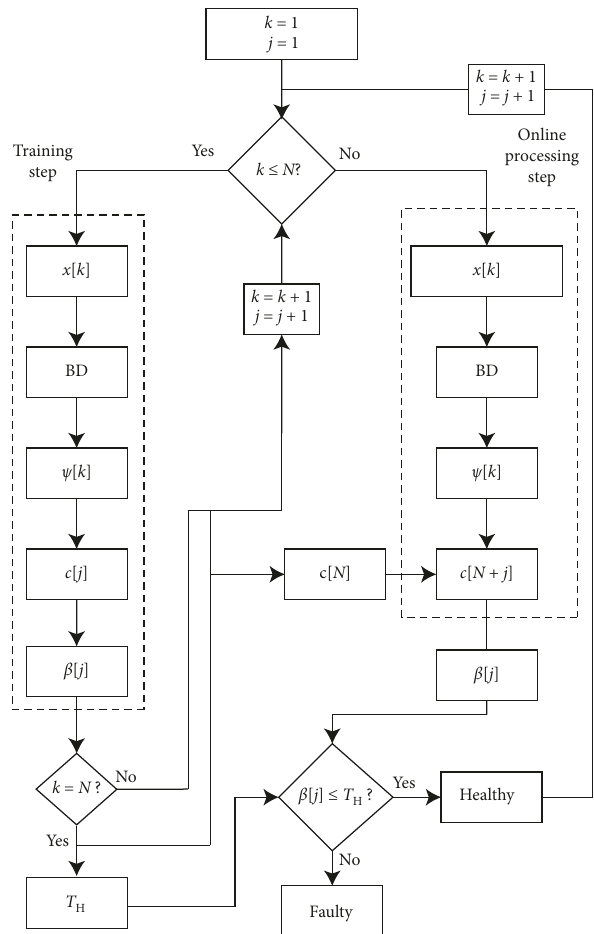
Figure 2: Flow chart of the proposed diagnostic